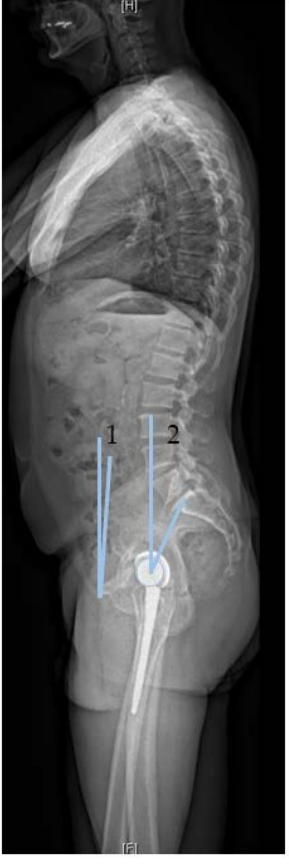
Figure 3. Measurement of the two methods for pelvic tilt: Method 1 , used by arthroplasty surgeons, defined by the angle between the vertical axis and a line from the femoral heads to the midpoint of the S1 endplate; Method 2 , used by spine surgeons, defined by the angle formed between the coronal plane and a line from the anterior superior iliac spine to pubic symphysis.